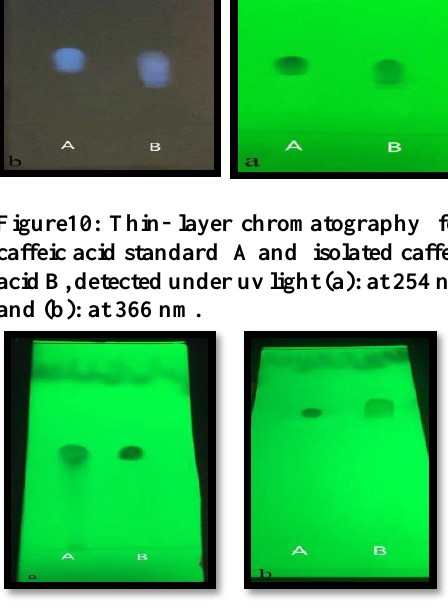
Figure 7 .a:Hplc of standard luteolin b: Hplc of isolated luteolin.